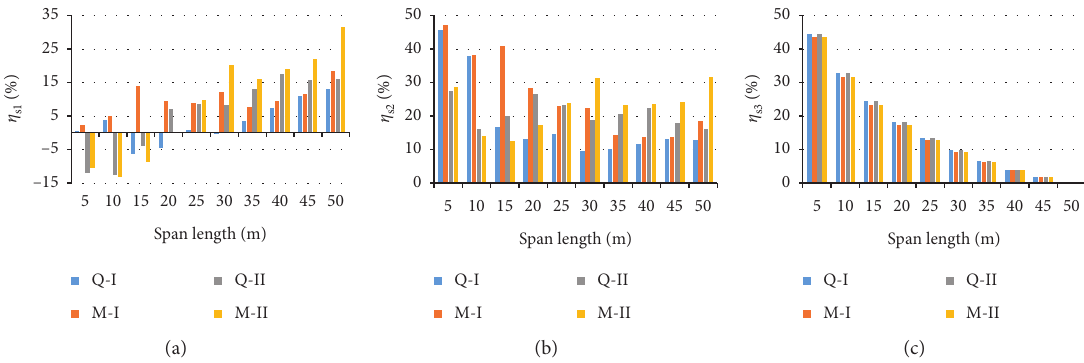
Figure 6: Comparison of the traffic loading effects without a dynamic load allowance: (a) η